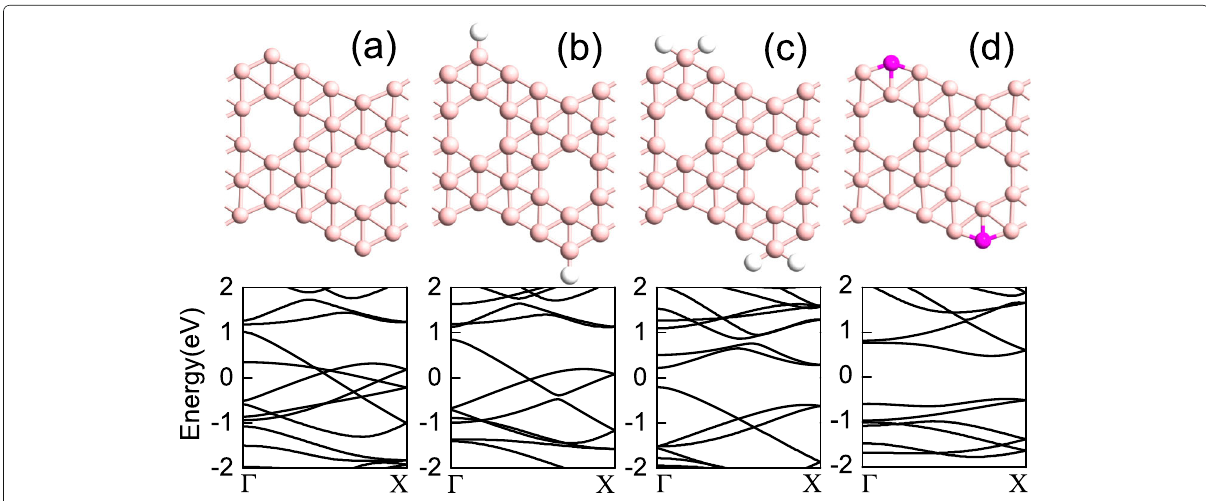
Fig. 1 The unit cell geometries (upper) and band structures (lower) for a unpassivated Z α BNR, b 1H-Z α BNR, c 2H-Z α BNR, and d N-Z α BNR, where the Fermi level is set to zero, and the pink, magenta, and white spheres represent boron, nitrogen, and hydrogen atoms, respectively